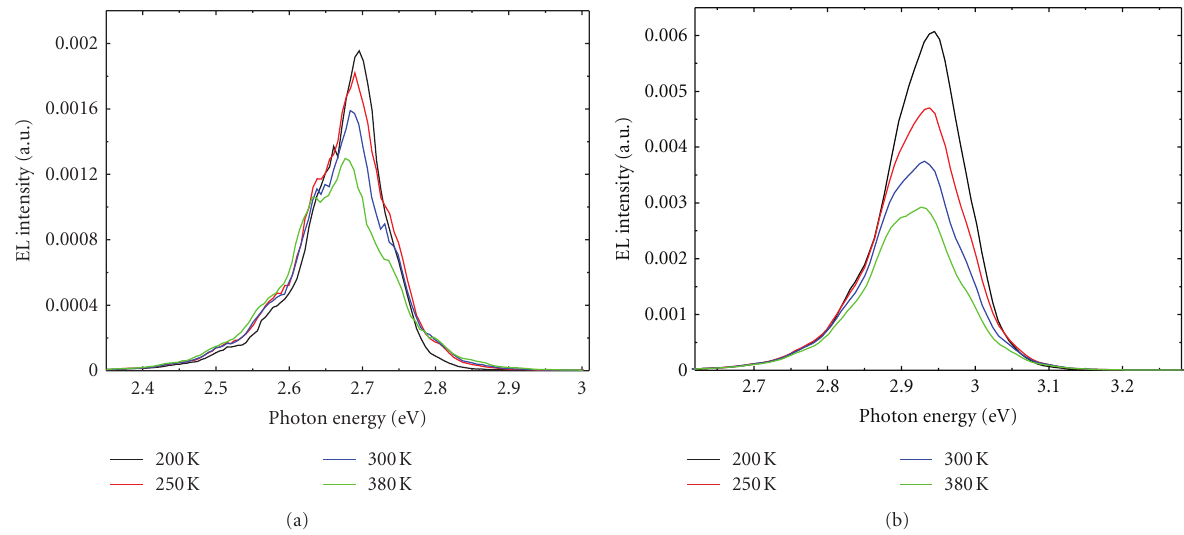
Figure 2: EL spectra of InGaN/GaN MQWs in the temperature range from 200 to 380 K for (a) sample with GaN barriers and (b) sample with MQBs. The driving current is 10 mA.